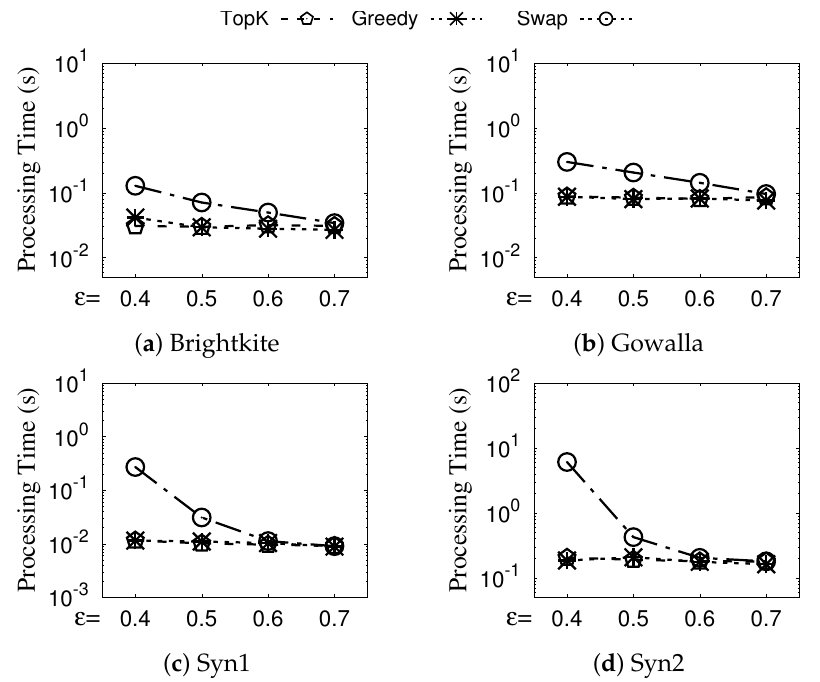
Figure 12. (Eval-VIII) Against existing algorithms (vary (cid:101)